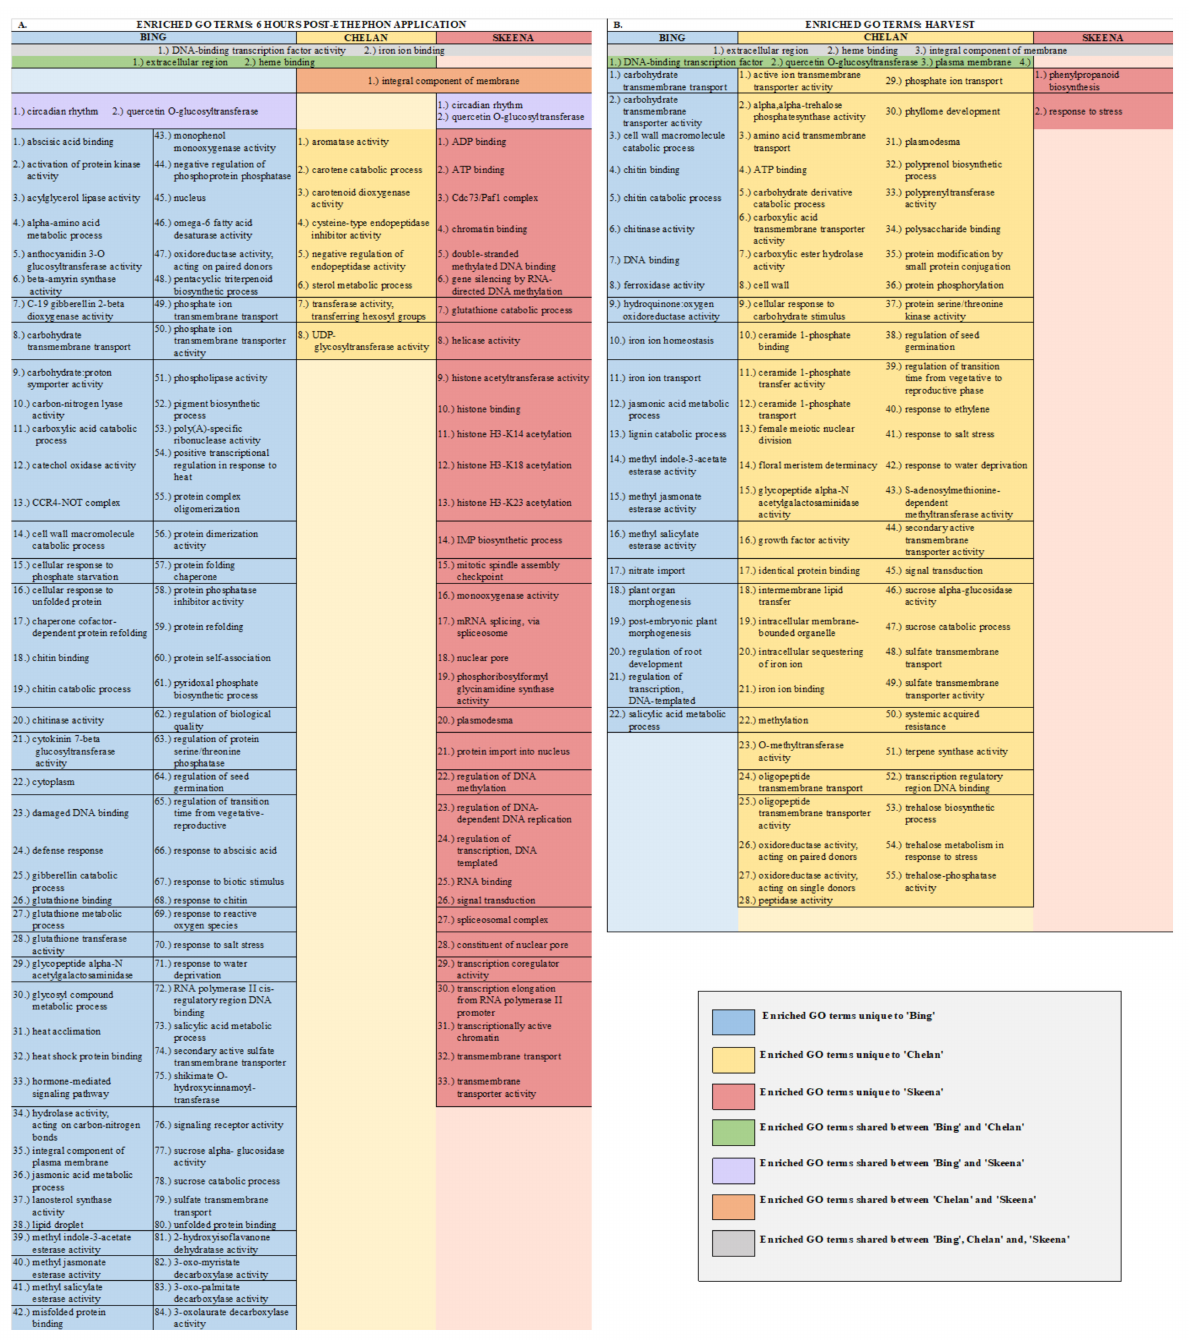
Figure 2. Chart displaying shared and unique enriched GO terms in ethephon-treated ‘Bing’, ‘Chelan’, and ‘Skeena’ at 6 h post-ethephon treatment ( A ) and at harvest ( B ). Enrichment results are based on Fisher’s Exact test with an FDR corrected p -value <